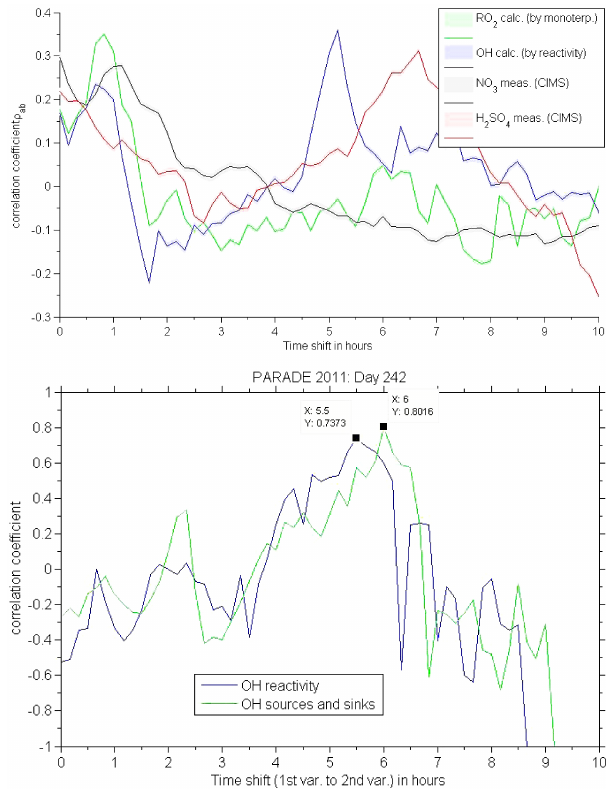
Figure 13. Top: cross-correlation of particle formation at 5nm with RO 2 (terp.), OH, NO 3 and H 2 SO 4 . Bottom: cross-correlation be- tween the particle formation rate at 5nm and the estimated OH con- centration using two different approaches. The maximum is found at τ of 5.5h (6h for the budget approach), resulting in a GR of 3.5nm/5.5h = 0.6nmh − 1 .